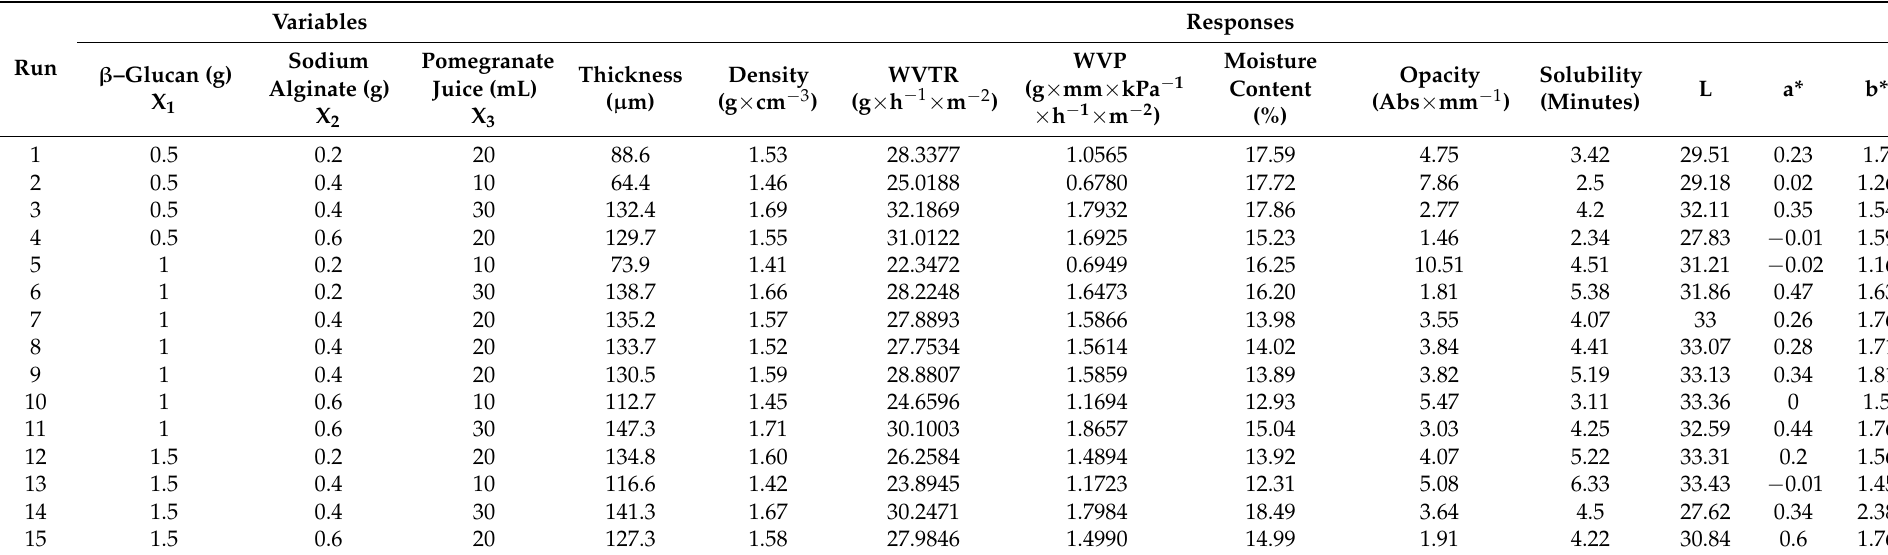
Table 4. Second order design matrix used to evaluate the effects of process variables and values of experimental responsefor films.